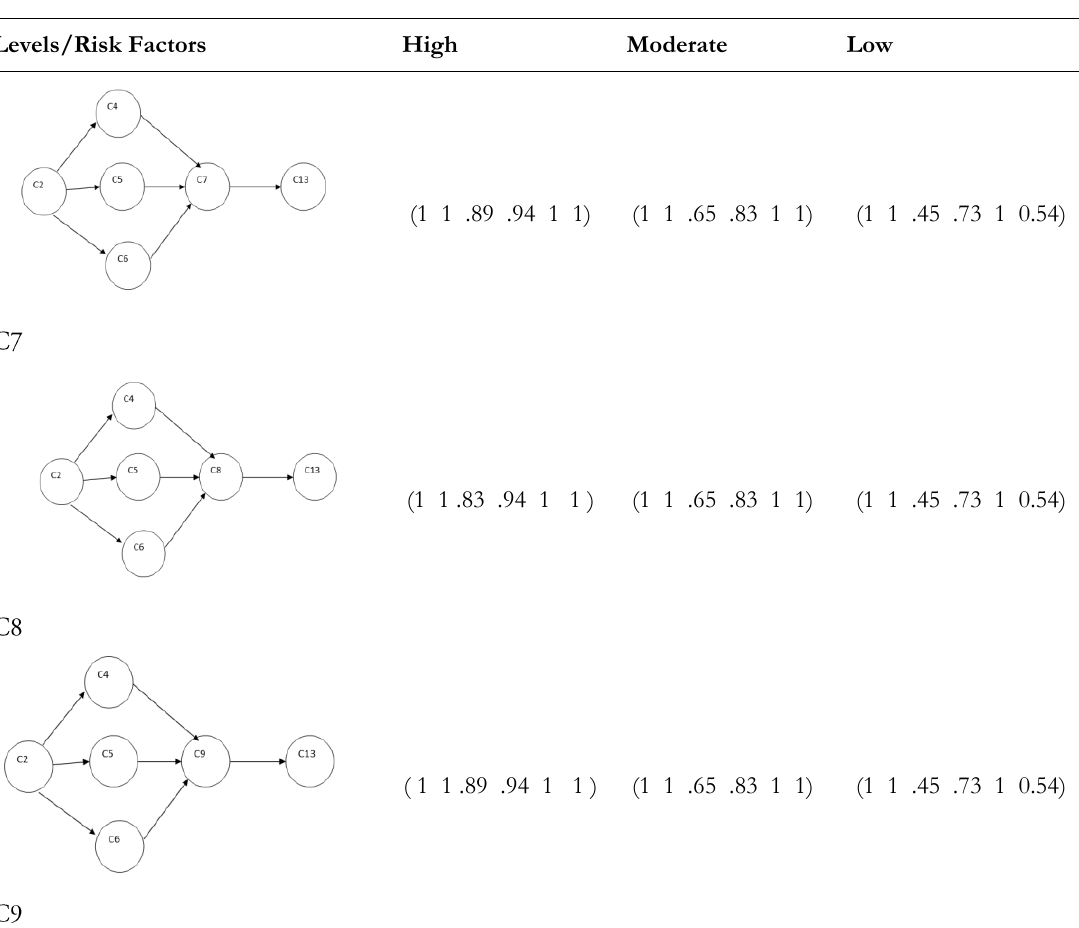
Table 3. Diverse levels of parametric